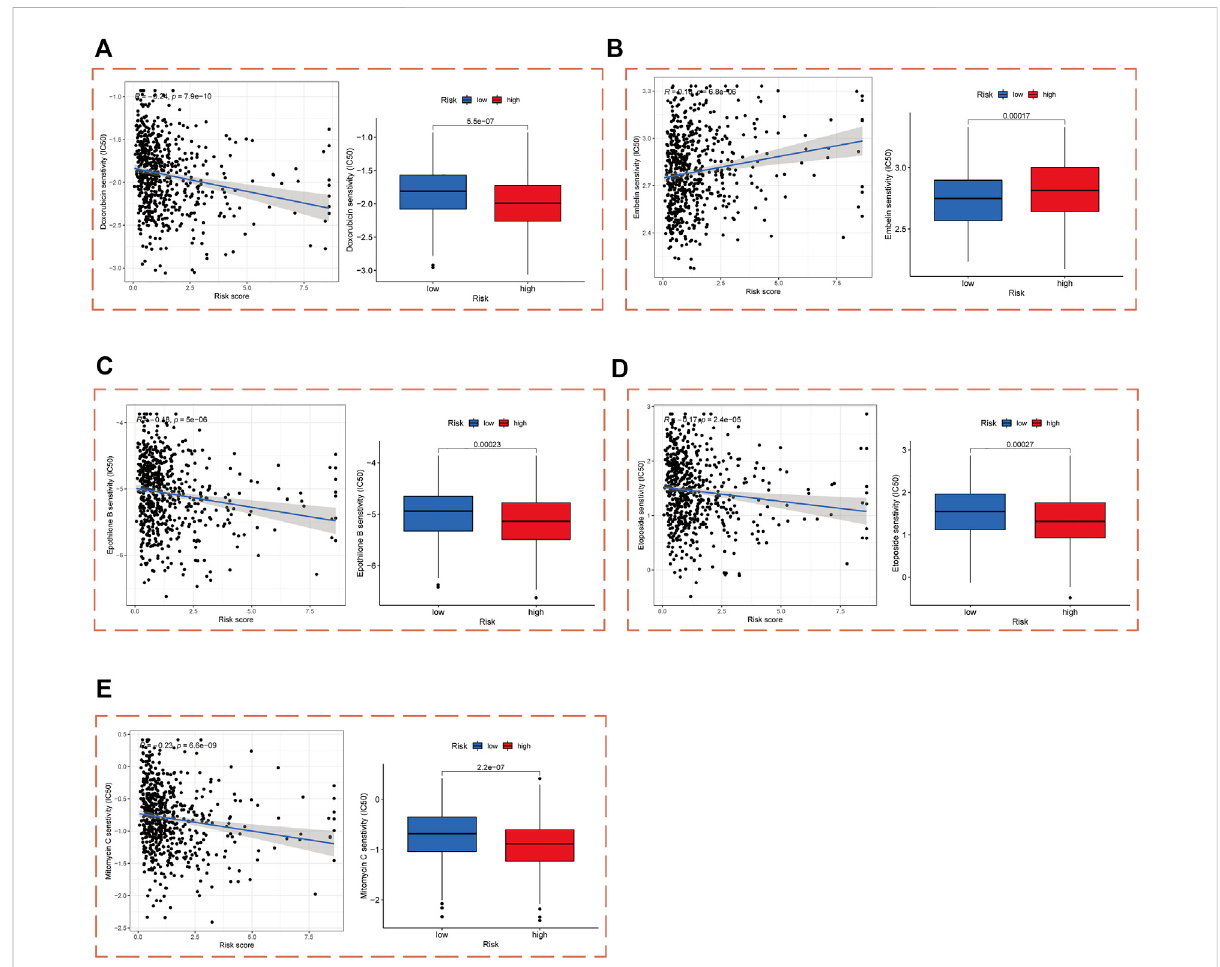
FIGURE 7 Drug sensitivity analysis in high- and low-risk cohorts. IC50 values of (A) Doxorubicin, (B) Embelin, (C) Epothilone B, (D) Etoposide, and (E) Mitomycin C in high- and low-risk